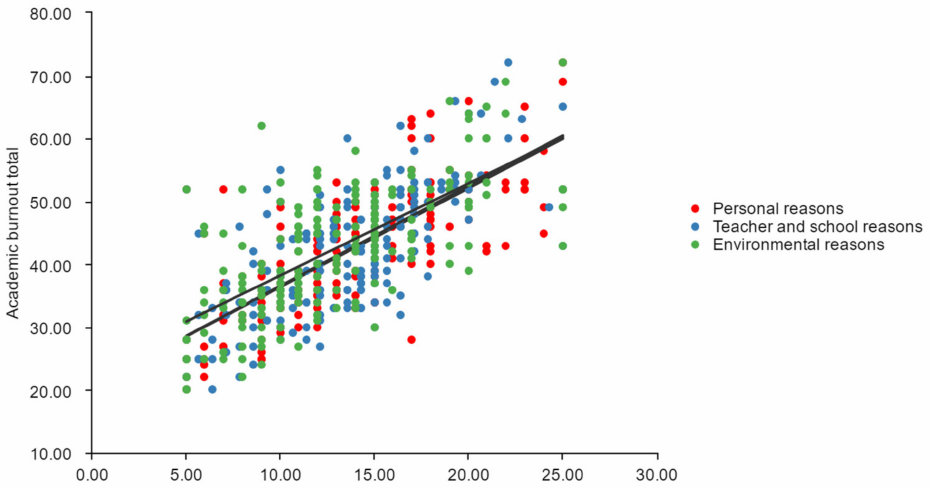
Figure 3. Relationship between academic burnout and personal, school, and environmental causes.